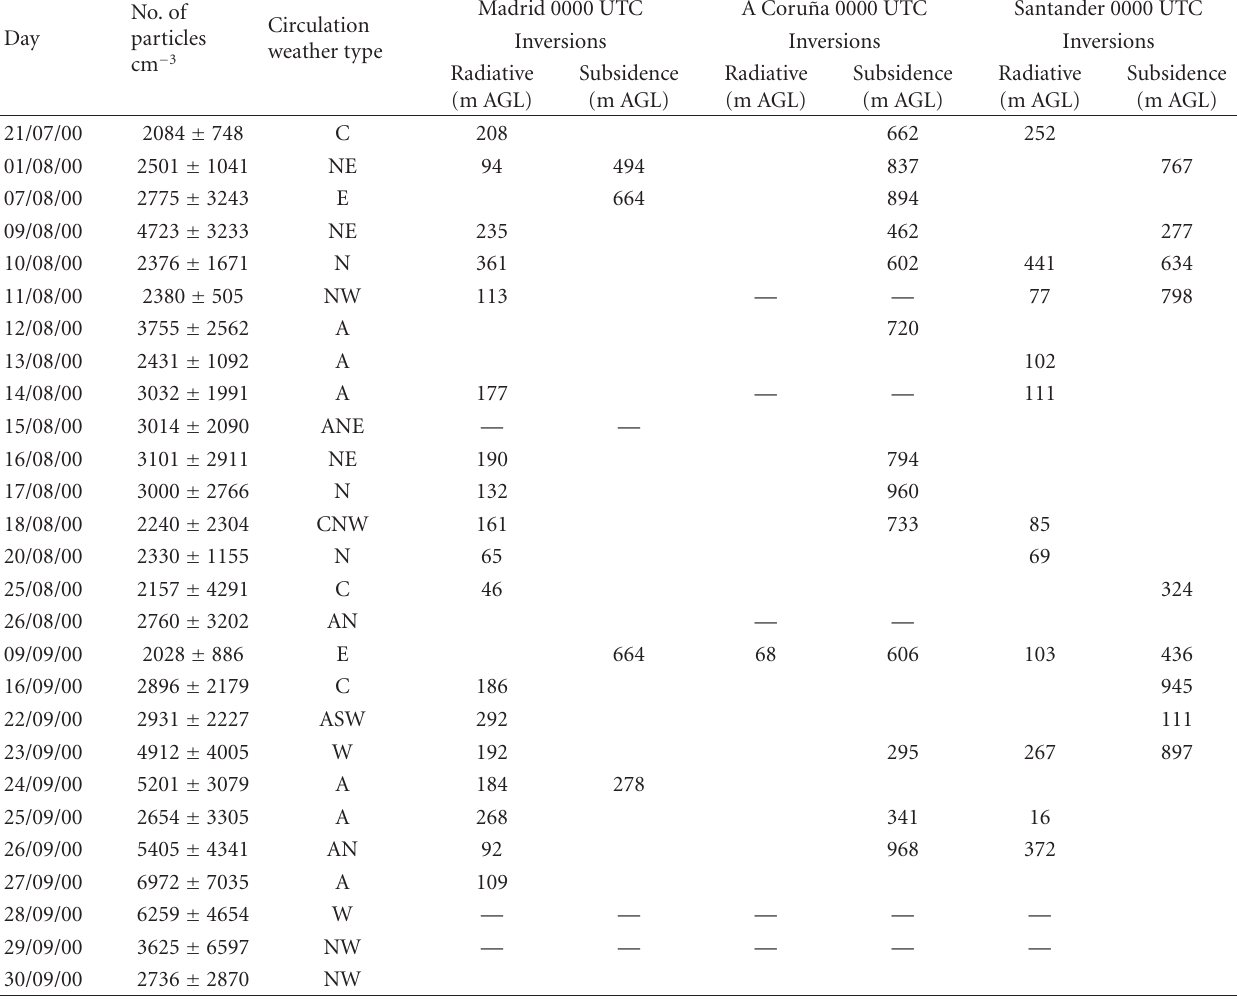
Table 6: Weather types and radiative and subsidence thermal inversions during the days with an average number of particles exceeding 2000 particles cm − 3 (—) means the data are not available.